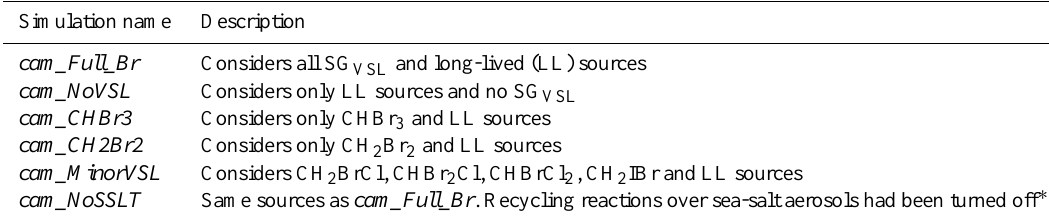
Table 3. Description of the CAM-Chem setup used for different global sensitivity simulations.